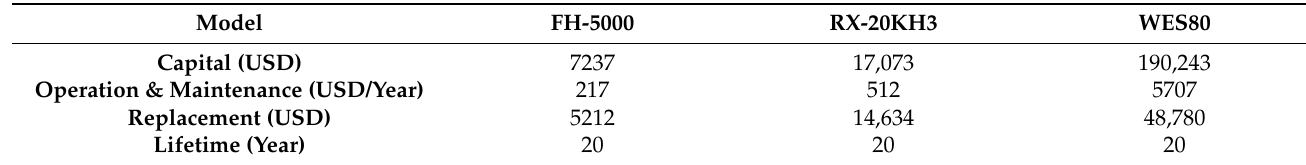
Table 1. Financial details of selected wind